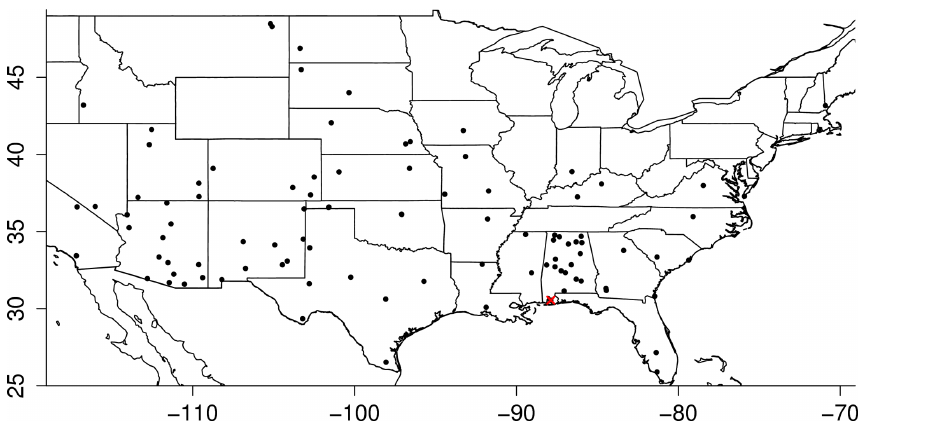
Figure 1. Map showing the location of the 99 selected USCRN stations. The red cross denotes station AL-Fairhope-3-NE, which was chosen for illustration